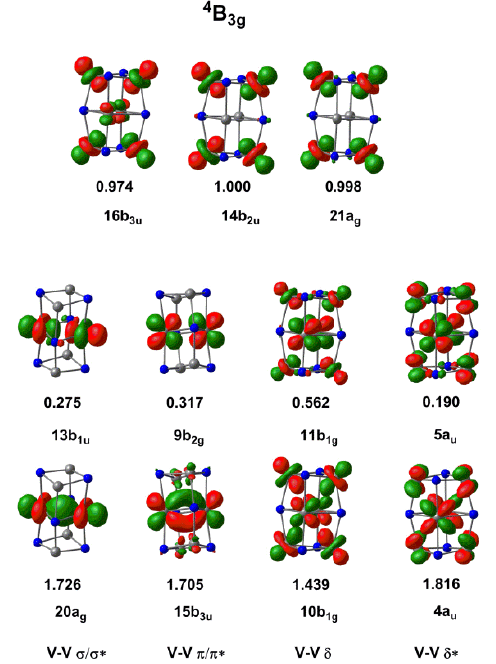
Figure 5. Natural orbital occupations for the 4 B 3g state of [V 6 N 6 ] + with a CAS(11,11) active space.